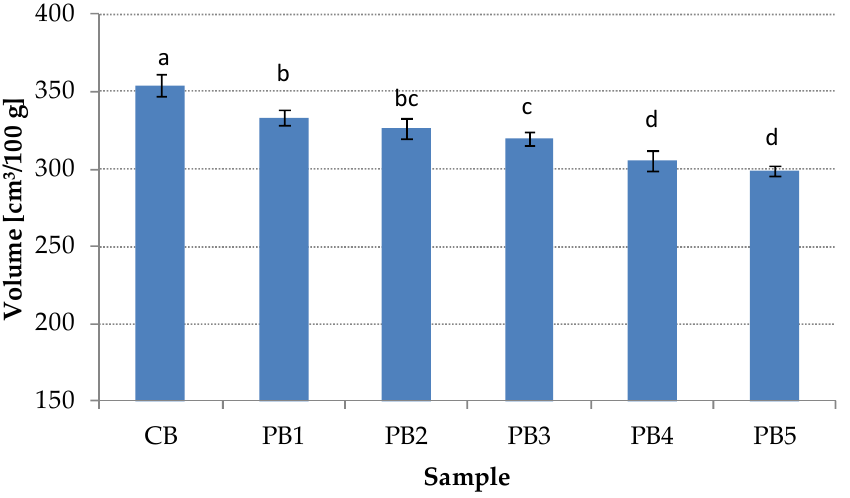
Figure 2. Volume of the control bread (CB) and bread with parsley (PB1, PB2, PB2, PB3, PB4, and PB5: bread with 1, 2, 3, 4, and 5% of parsley powder, respectively). Values followed by the same letter (a–d) are not significantly different ( p < 0.05), n =